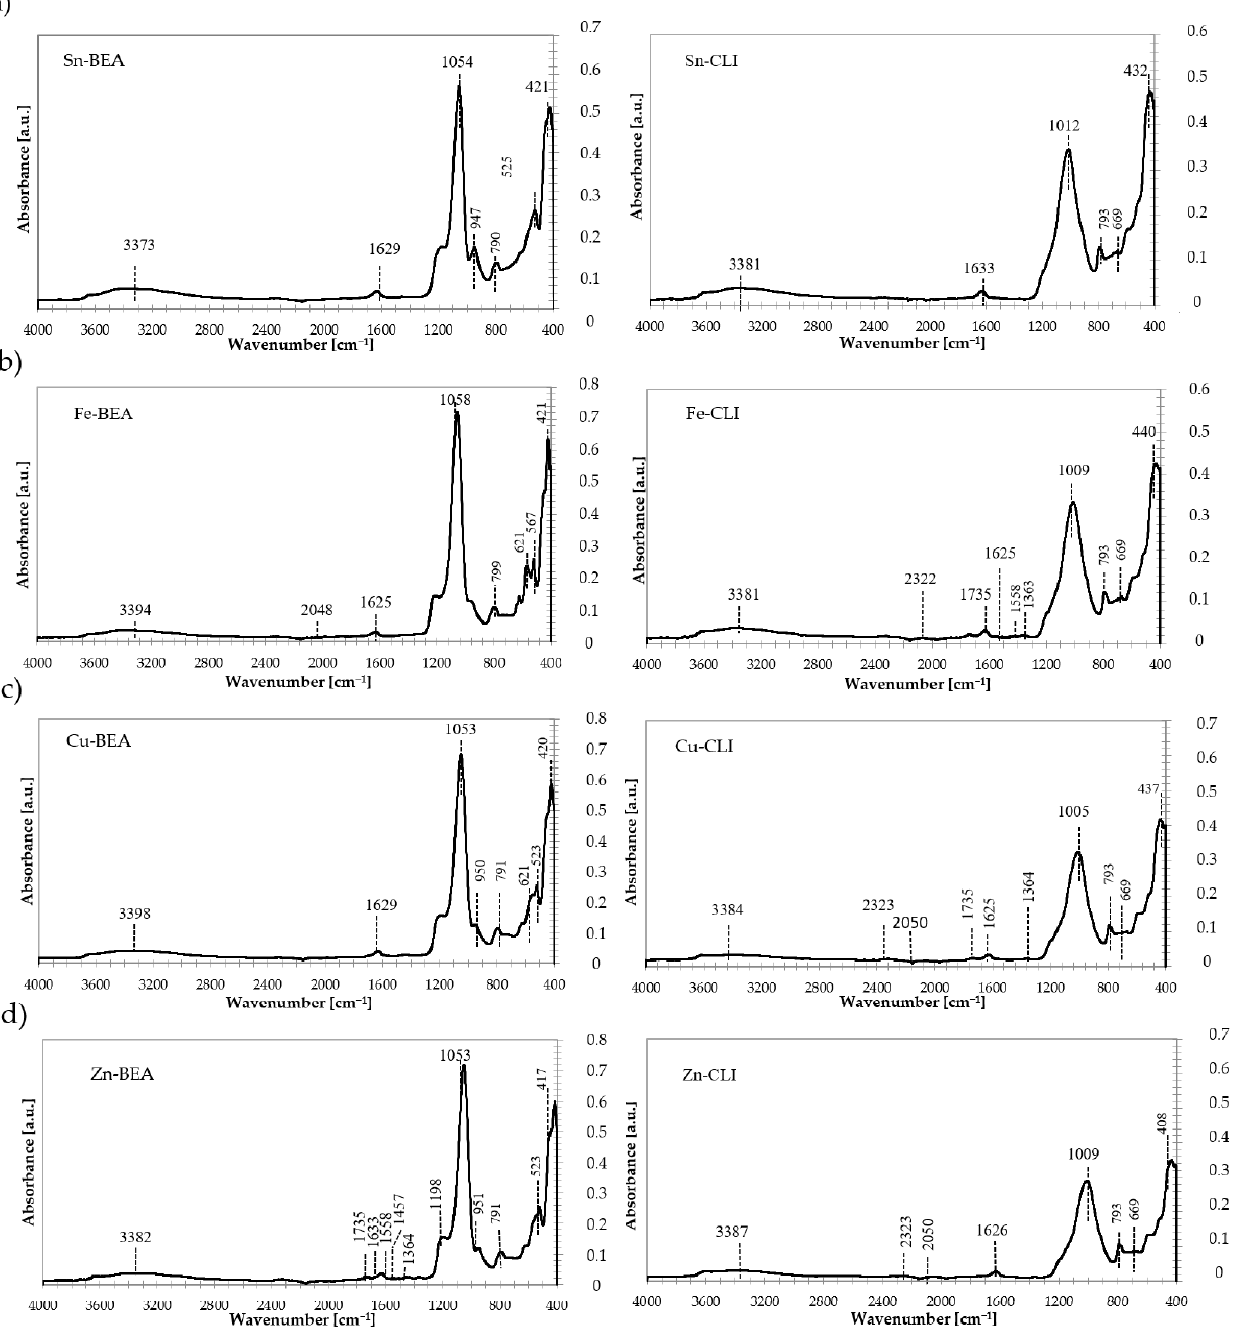
Figure 9. ATR FTIR spectra for BEA (left column) and CLI (right column): ( a ) Sn, ( b ) Fe, ( c ) Cu and ( d ) Zn.